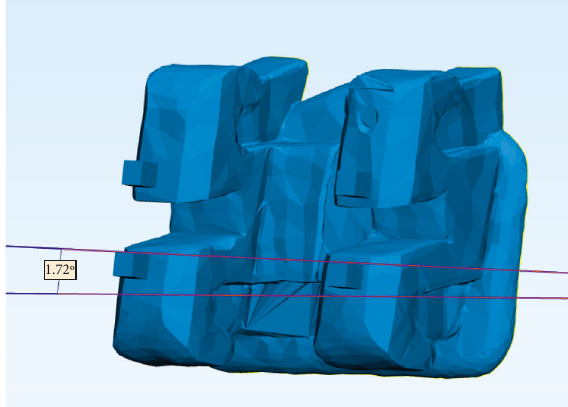
Figure 12: Tipping differences between the superimposed